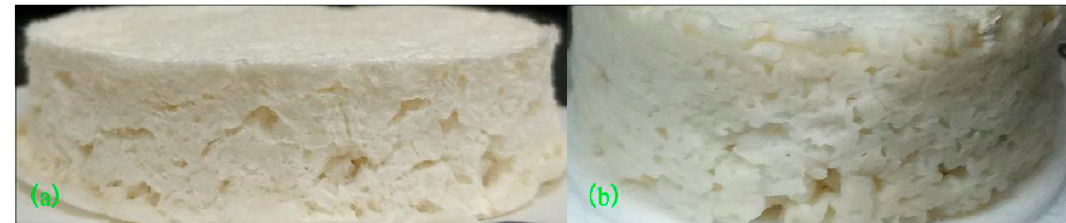
Figure 8. Comparison image of the basic ( a ) and OMMT ( b ) foam materials.